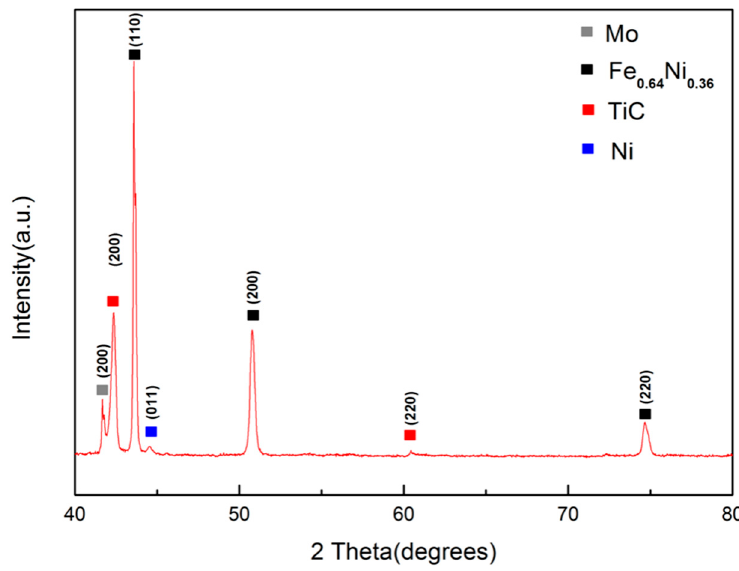
Figure 9. XRD pattern of the heat treated multi-scale cermet coating fabricated by laser cladding.